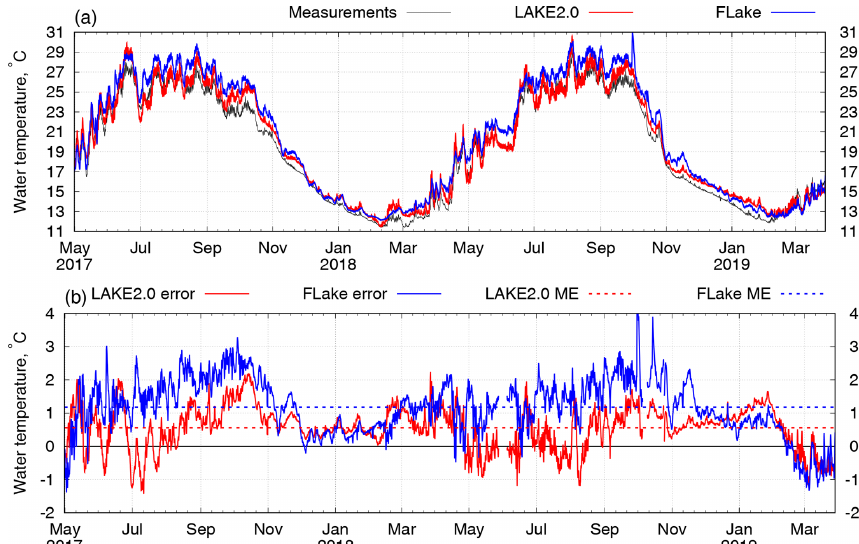
Figure 3. (a) Time series (6h moving average) of the Alqueva water temperature in mixed layer showing measured (black curve) and modelled results from LAKE 2.0 (red curve) and FLake (blue curve). (b) Temperature differences (6h moving average) between observations and LAKE 2.0 (red curve) and FLake (blue curve). Dashed lines show the corresponding mean errors for LAKE 2.0 and FLake. Table 2. Statistical results of mixed layer (ML) water temperature intercomparison. MAE – mean absolute error. Correlation Mean error, ◦ C MAE, ◦ C Time periods LAKE 2.0 FLake LAKE 2.0 FLake LAKE 2.0 FLake